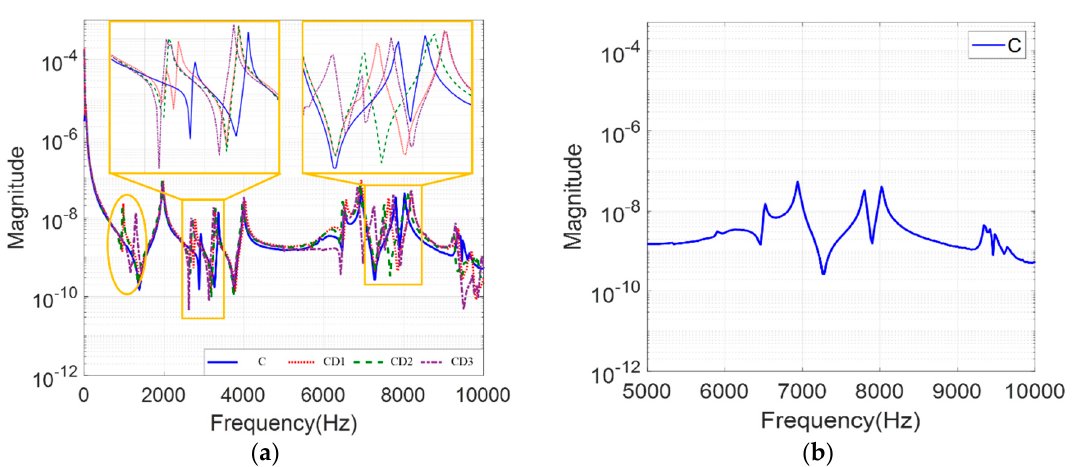
Figure 4. FRF results from the impact of porcelain. ( a ) FRF results of normal and cap damage; ( b ) FRF result of 5 to 10 kHz at normal C.